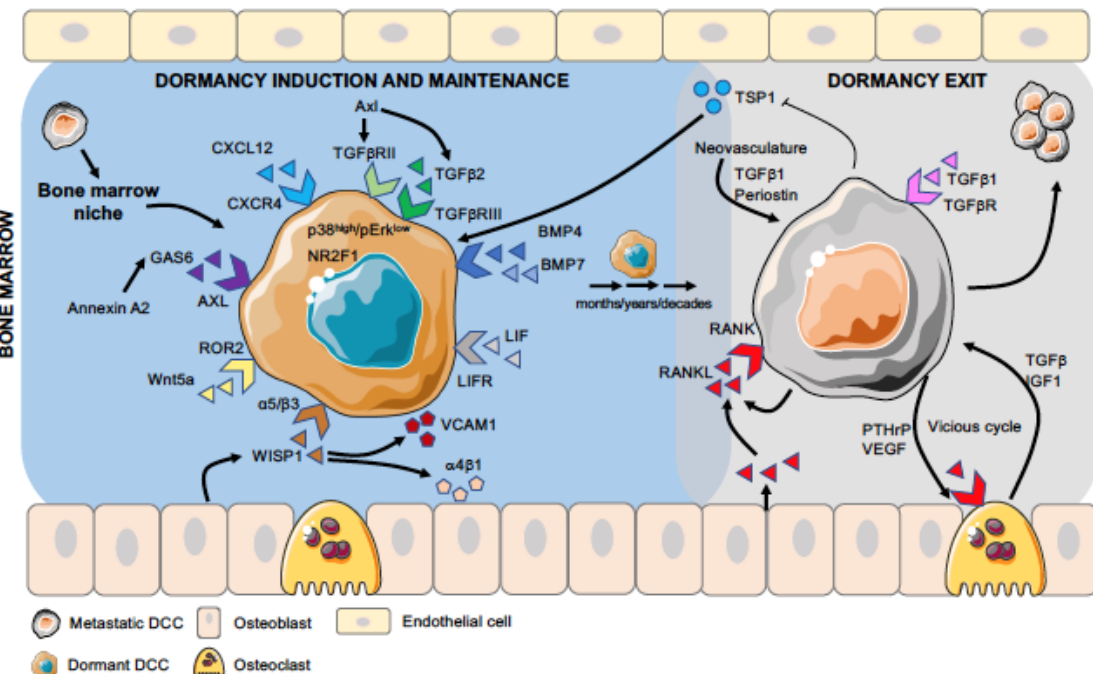
Figure 1. Different stages of DCC dormancy and activation in bone marrow. Disseminated cancer cells (DCCs), after arriving in the bone marrow, encounter different niches (e.g., osteogenic, peri-sinusoidal, and peri-arteriolar), where